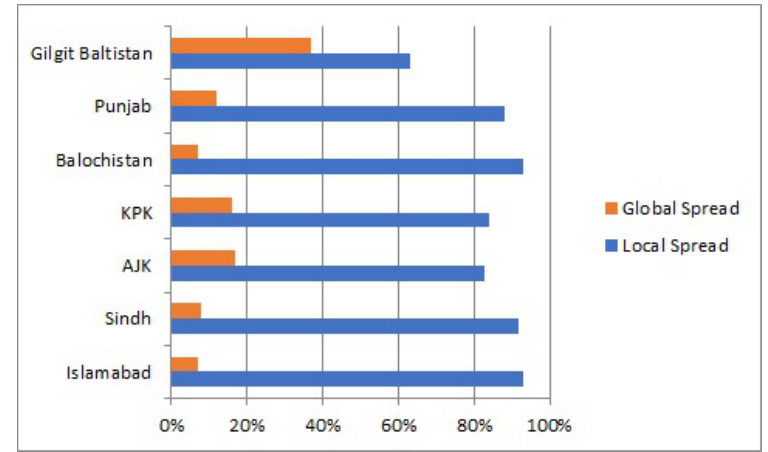
Figure 5. Global vs. Local spread of COVID-19 in